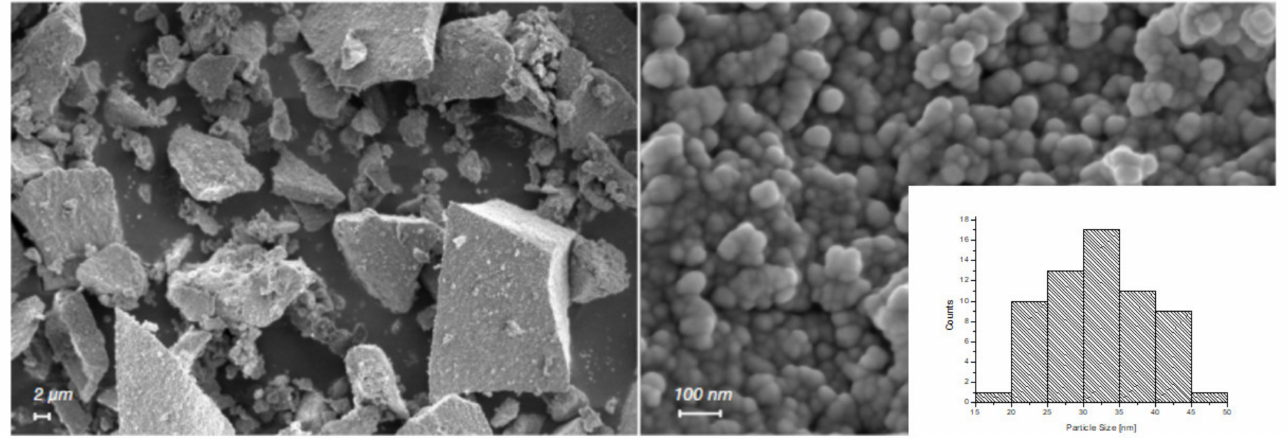
Figure 1. FESEM image of n-ZnO at 5K ( left ) and 250K ( right ) magnification. Particle size distribution is shown in the bottom right corner.